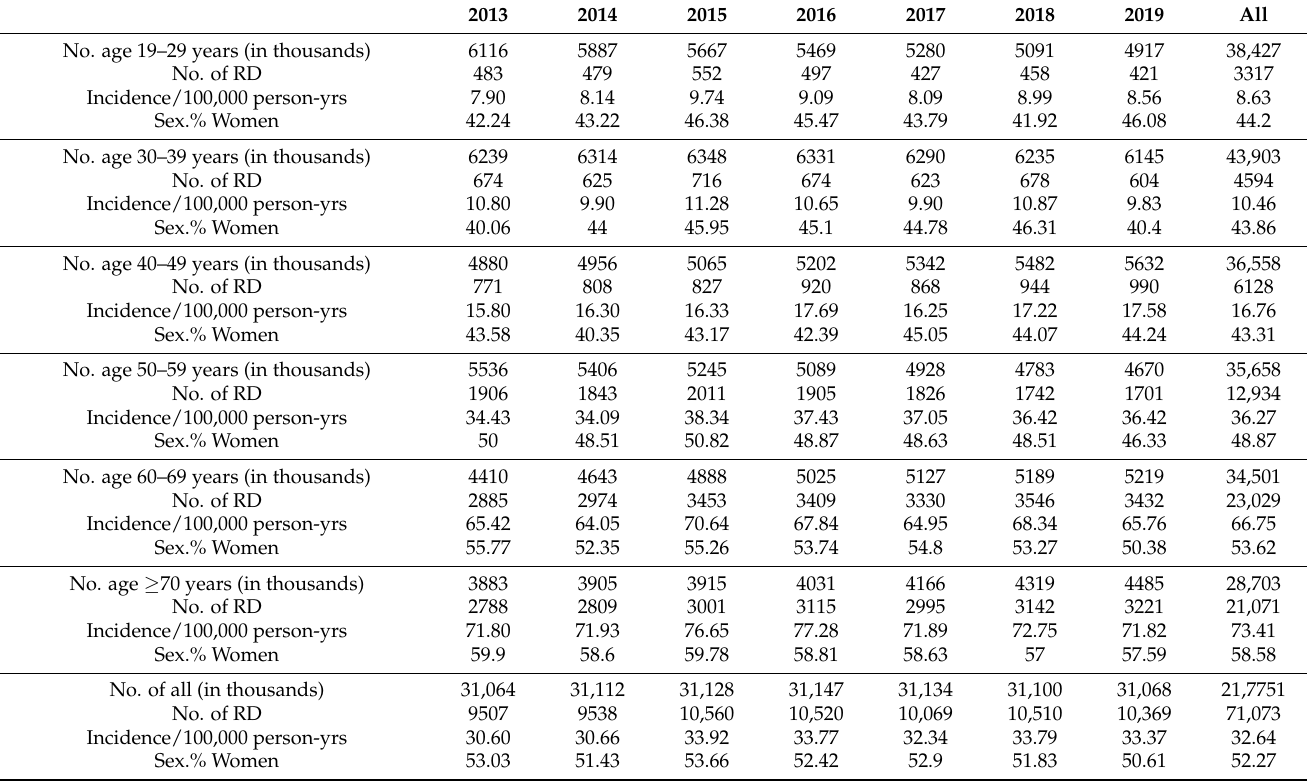
Table 1. Age-standardized incidence of RD among Polish adults from 2013 to 2019 by age group.